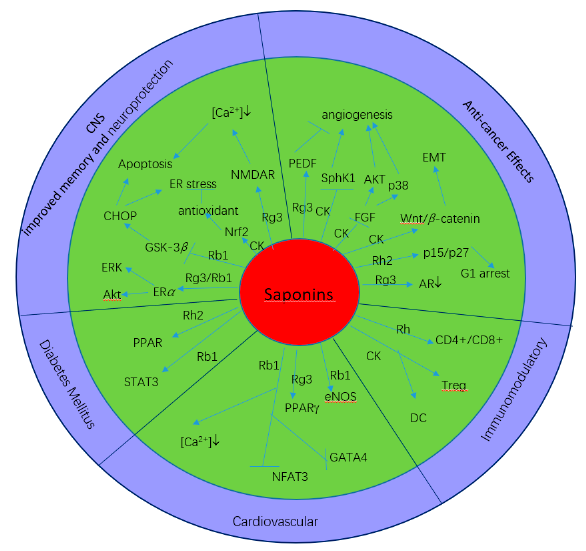
Figure 3 . Pharmacological profiles and mechanisms of ginseng saponins. Figure 3. Pharmacological profiles and mechanisms of ginseng